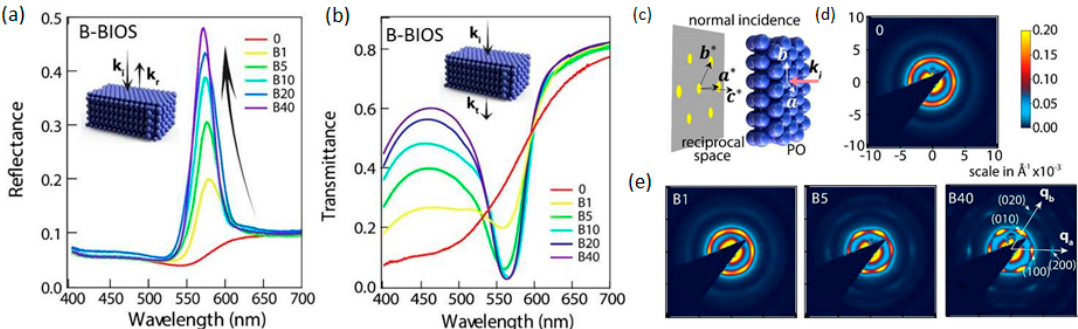
Figure 3. ( a ) Reflectance spectra of B-BIOS samples, with number of shear oscillations indicated in the caption; ( b ) corresponding transmittance spectra of B-BIOS samples; ( c ) Illustration of small-angle X-ray scattering (SAXS) at normal incidence with incident wave vector k i , unit vectors a , b of hexagonal lattice, a *, b * and c * are corresponding reciprocal lattice unit vectors; ( d ) SAXS pattern of samples prior to BIOS at normal incidence, with q a,b along a *, b *, respectively; ( e ) shows corresponding SAXS patterns of B-BIOS samples. All SAXS images are (10 × 10) × 10 − 3 Å and on the same colour scale. (Adapted from Ref. [28] with permission of Nature Publishing Group).